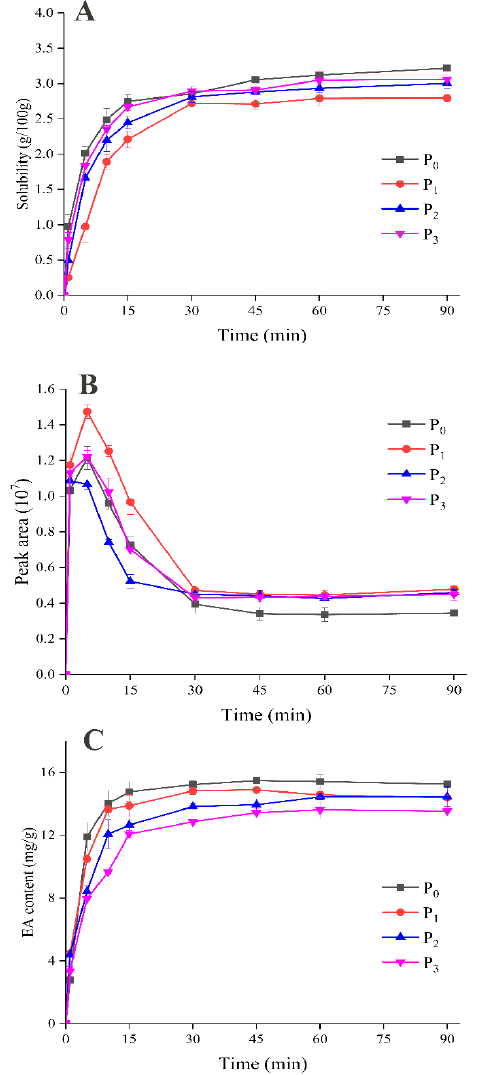
Figure 8. Changes of dynamic dissolution, Ethyl acetate (EA) release and content of EA content in liquid phase after 90 min of dissolution of powdered microcapsules. (( A ) Solubility, ( B ) EA release, ( C ) EA content).